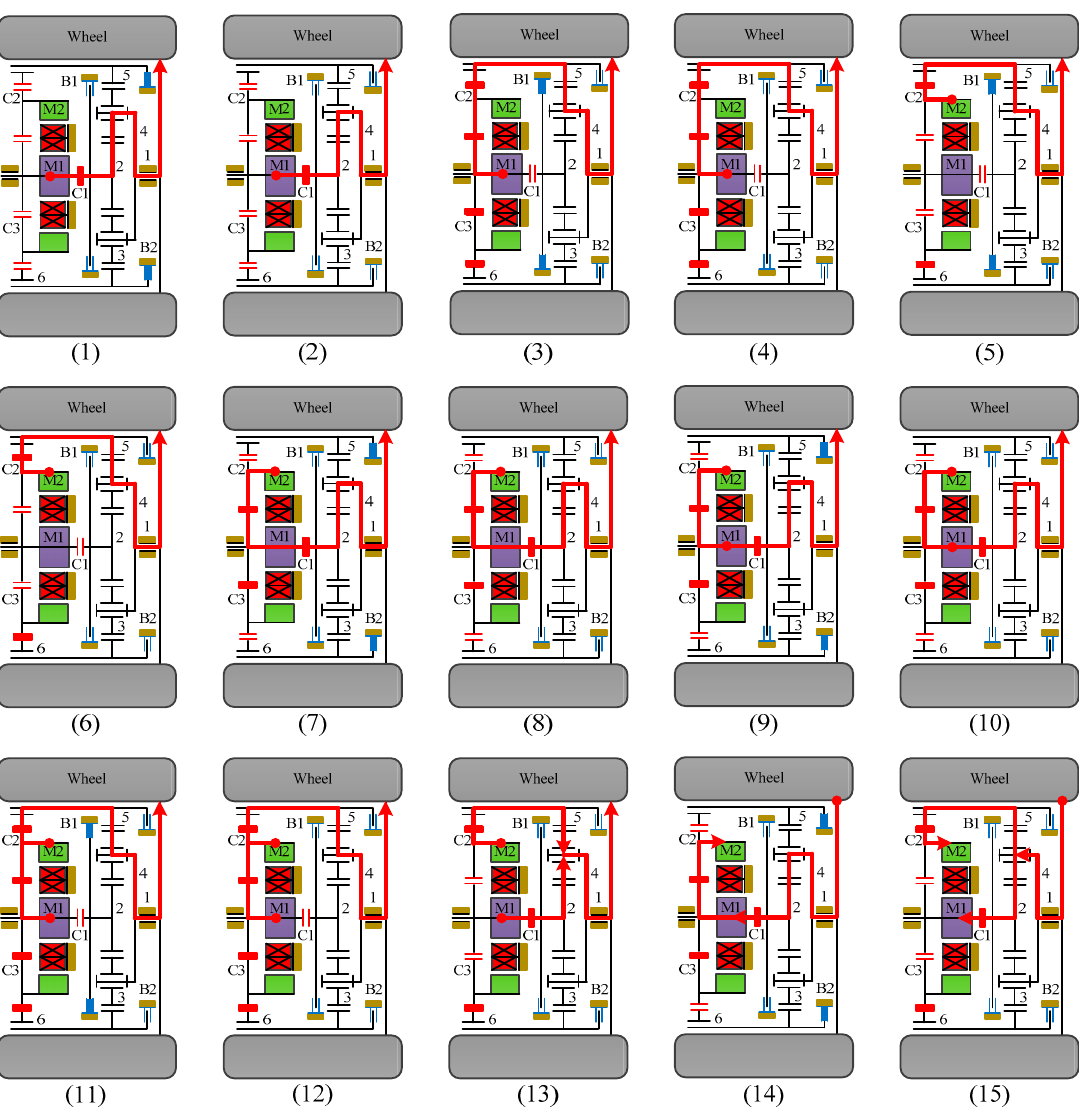
Figure 12. Operation modes of the novel motor transmission.